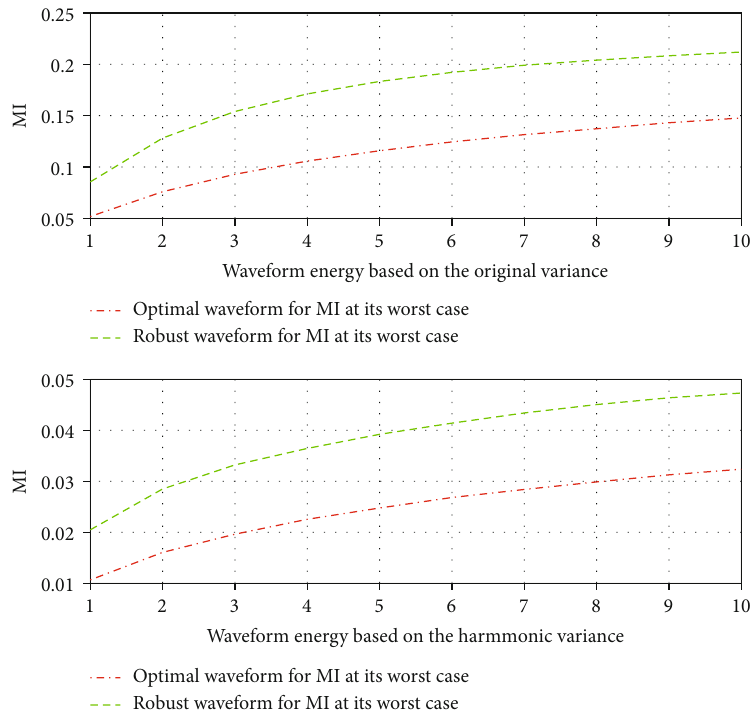
Figure 7: MI comparison of four targets based on original variance and harmonic variance.